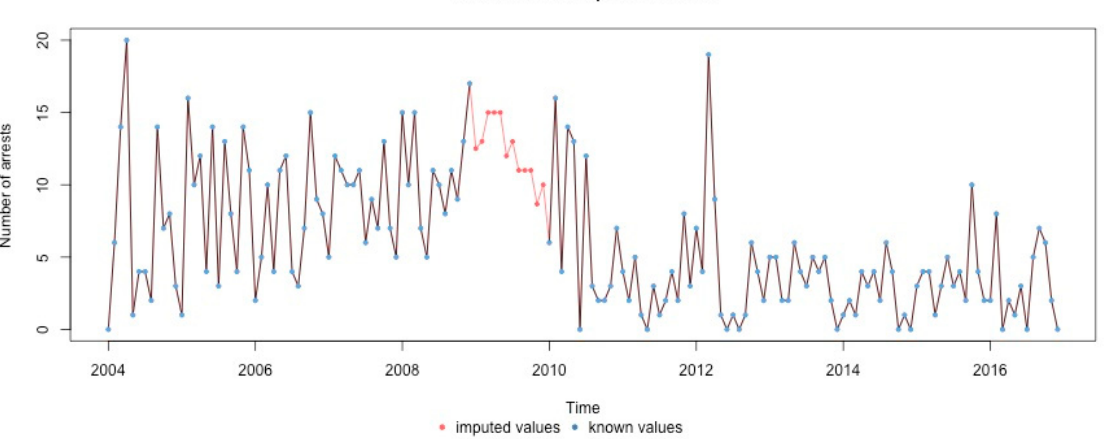
Figure A17. Heroin Czech nationals arrests 2004–2016 in the Czech Republic—imputed missing values.